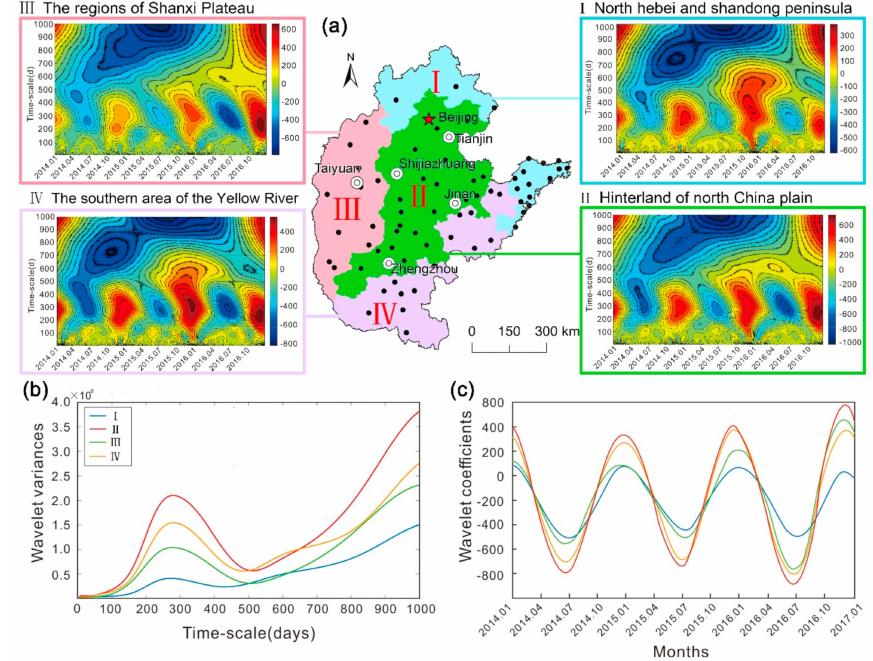
Figure 5. ( a ) Isograms of wavelet coe ffi cients of AQI for four regions of North China. The abscissa is the local time (month) and the ordinate is the wavelet scale (in days). ( b ) and ( c ) are wavelet variance curves and wavelet coe ffi cient curves of AQI of the four